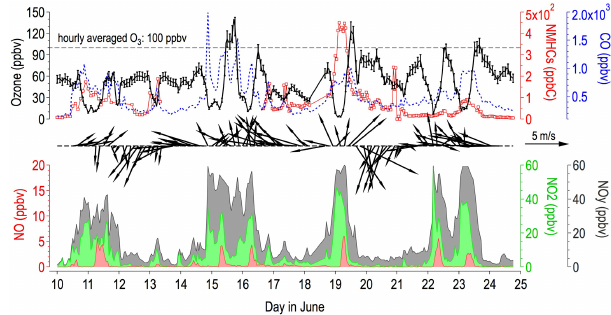
Figure 2. Time series of O 3 , CO, NMHCs, NO, NO 2 , NO y and wind information at the site during the field